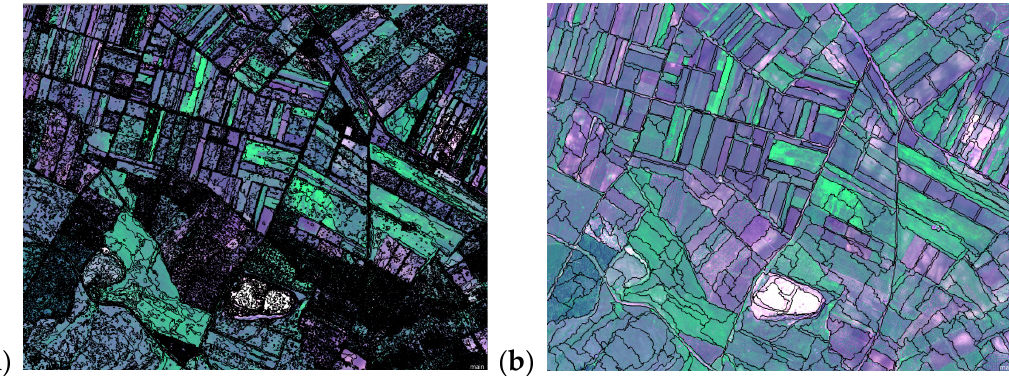
Figure 5. Different segmentations are superimposed to a detail of the input images: a finer “small objects” one ( a ) and a coarser “large objects” one ( b ).